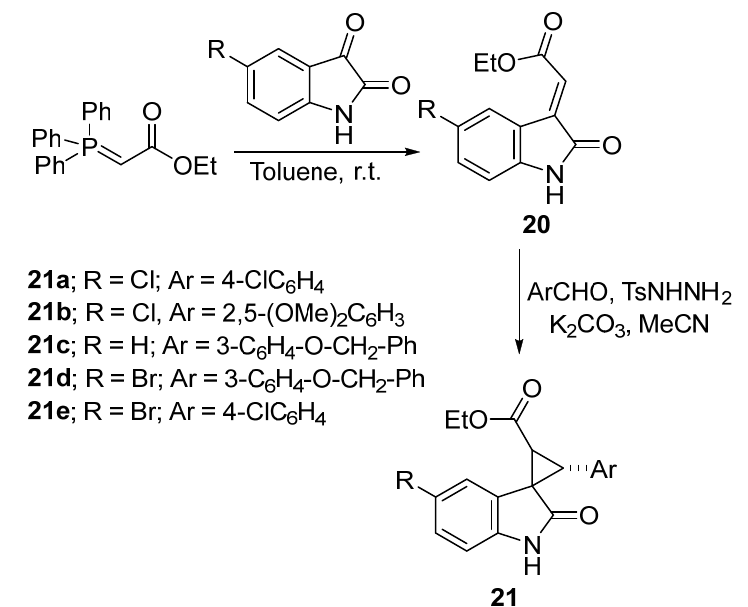
Scheme 1. Synthesis of 3-spirocyclopropyl-2-oxindoles 21 .